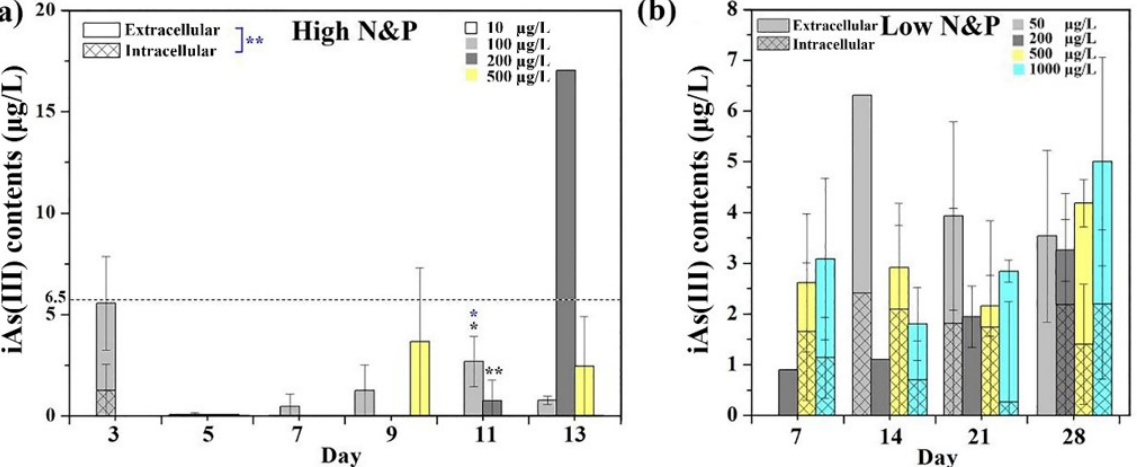
Figure 5. The intracellular and extracellular iAs(III) concentrations varied with incubation time that exposed different iAs(V) concentrations in the high ( a ) and low ( b ) nutrient sets. Note: No significant variations of intracellular and extracellular iAs(III) concentrations during incubation time, respectively, between each of two groups of ambient iAs(V) concentrations; blue * indicates significant variations between intracellular and extracellular iAs(III) concentrations in four groups of ambient iAs(V) concentrations. Black and blue * on column bars indicate significant variations of extracellular and total iAs(III) concentration with incubation time for each group of ambient iAs(V) concentrations; no significance was found for intracellular iAs(III) concentration. Significance levels below 0.05 (*) and 0.01 (**) are denoted in the figure. Line indicates value as the largest intracellular and extracellular iAs(III) concentration in the low nutrient